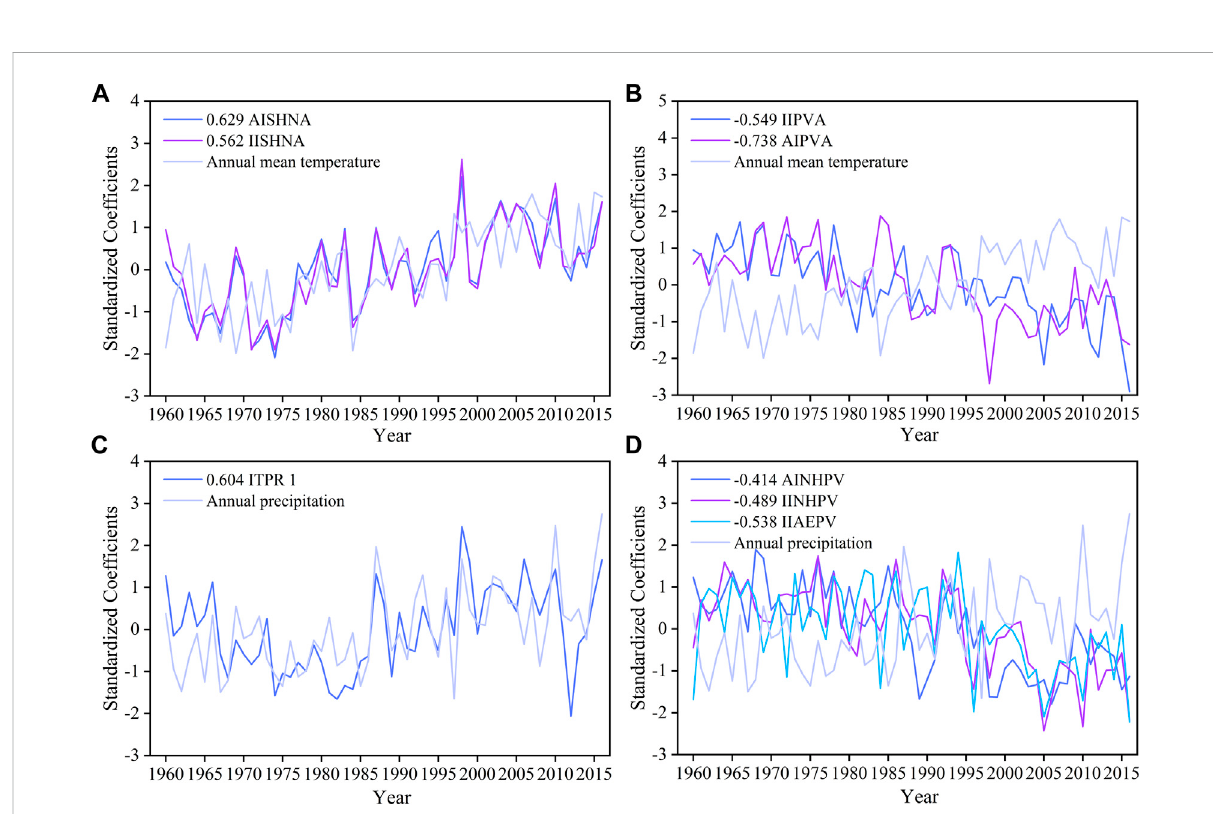
FIGURE 6 Time series of the key atmospheric circulation indices and annual mean temperature (A,B) and precipitation (C,D) in XJ.